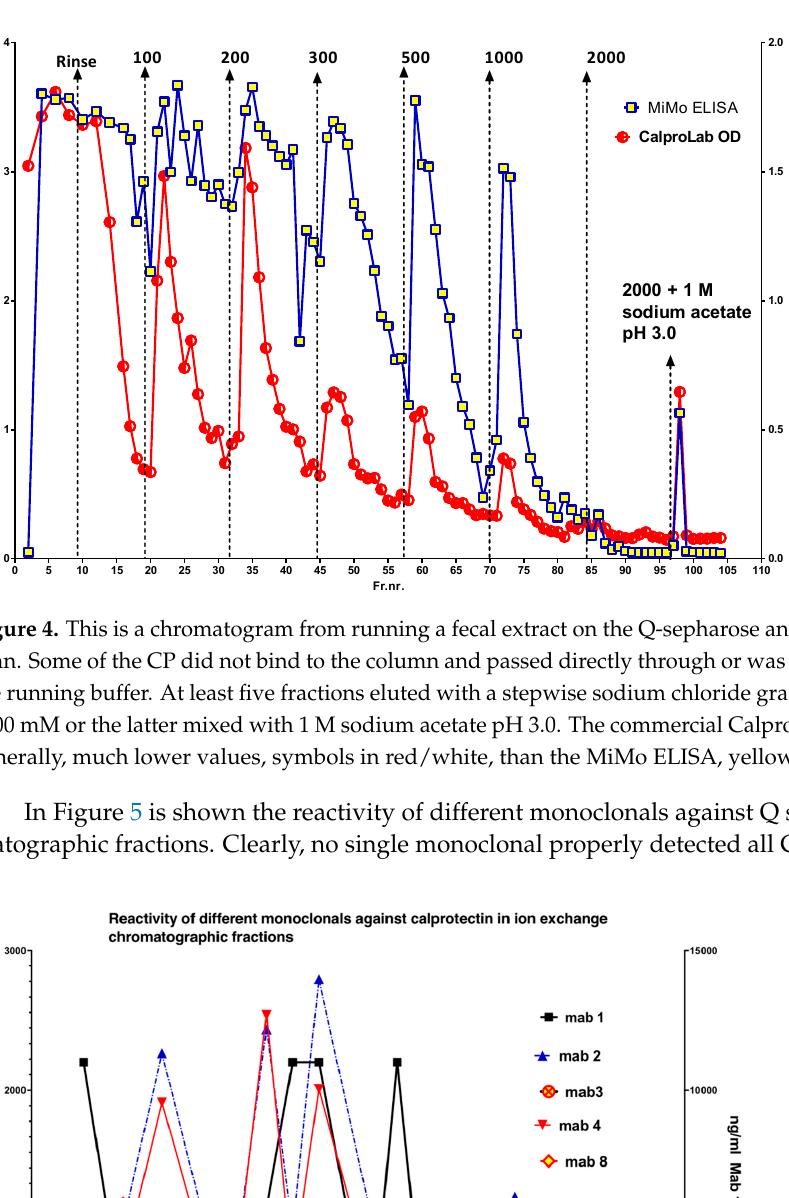
Figure 4 shows the peaks obtained when an IBD patient stool extract, prepared by use of a CalproLab kit, was run on the Q-sepharose chromatographic column. The fractions were run on a CalproLab ELISA kit and on the MiMo ELISA. Up to ten fractions, differing in net negative electric charge, were eluted from the column, and most of them reacted much stronger with the MiMo ELISA than the CalproLab kit, suggesting that the antibodies J. Mol. Pathol. 2022 , 3 , FOR PEER REVIEW in the latter do not detect properly fecal CP in all fractions.